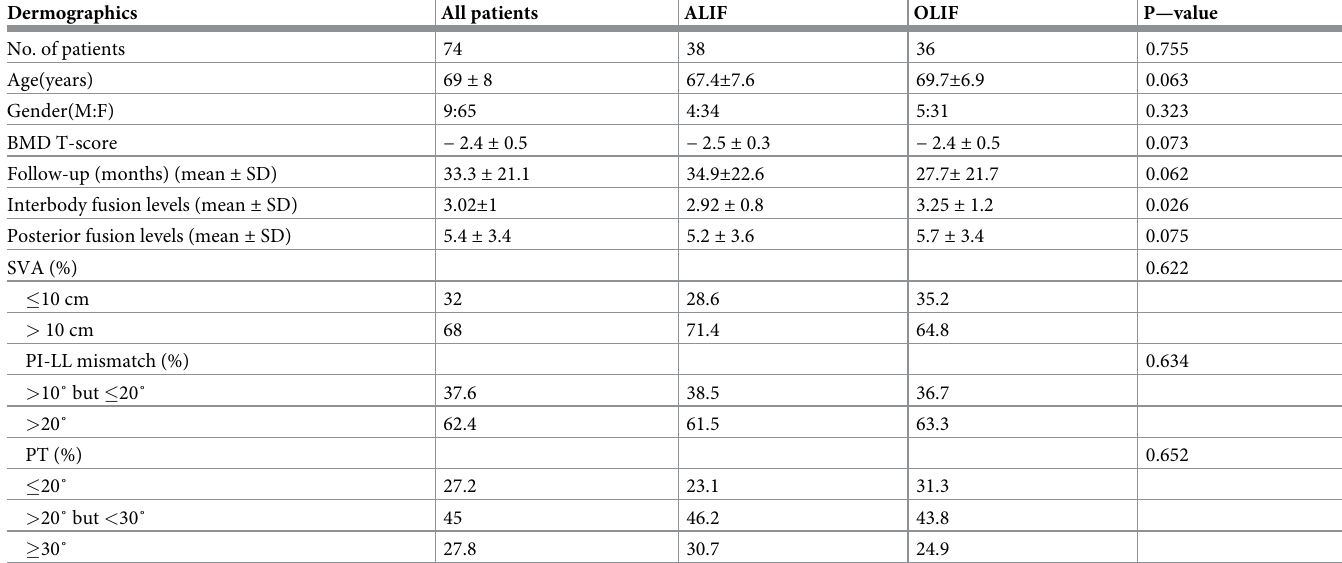
Table 1. Summary of demographic